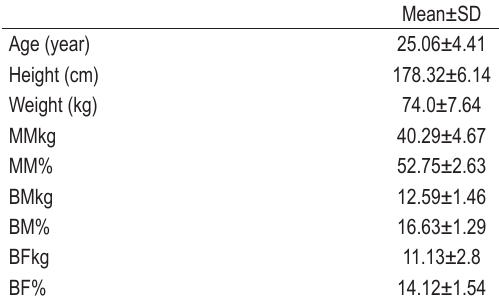
TABLE 1. Anthropometric data of the participants